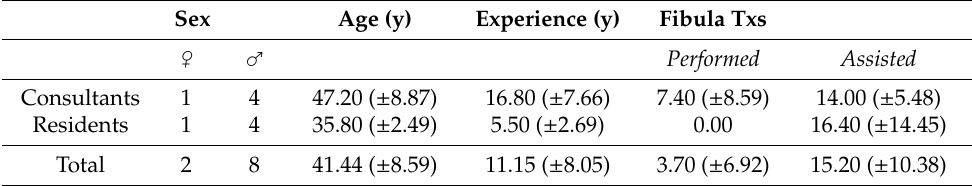
Table 1. Demographic variables of the participating